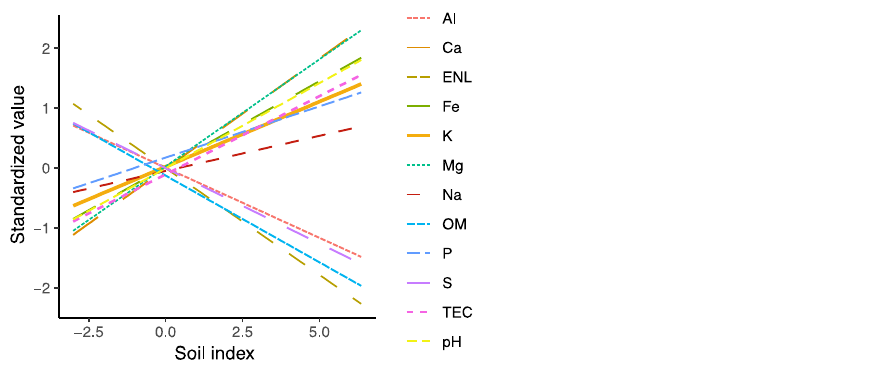
Figure 5. Correlation of soil chemical variables with soil index. Soil index is represented by an index based on ordination scores on the first axis of a principal component analysis (PCA) of all environmental variables.